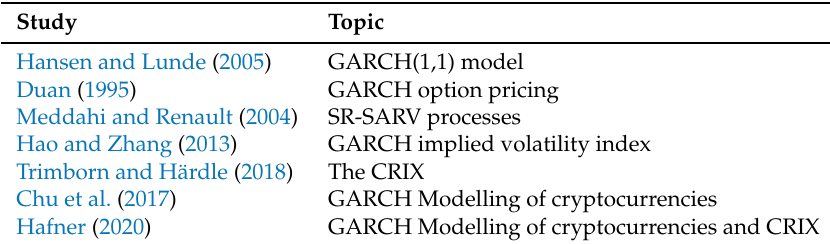
Table 1. Summary of important